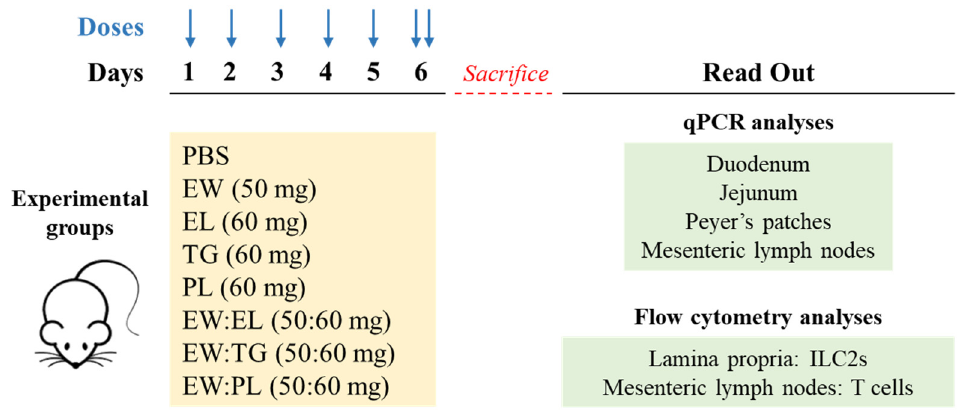
Figure 1. Experimental protocol in vivo. Mice were administered PBS, egg white (EW, 50 mg), egg lipids (EL, 60 mg), a triacylglyceride-enriched fraction (60 mg, TG), a phospholipid-enriched fraction (60 mg, PL), and their mixtures (50 mg:60 mg) with EW (respectively EW:EL, EW:TG, EW:PL) for 6 consecutive days.